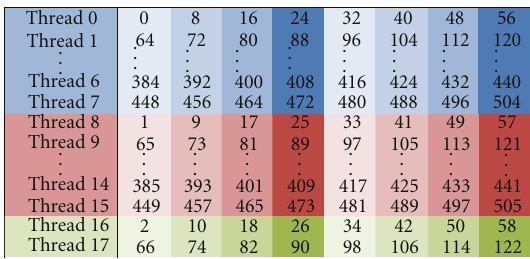
Figure 11: A sample of a load structure used in the new